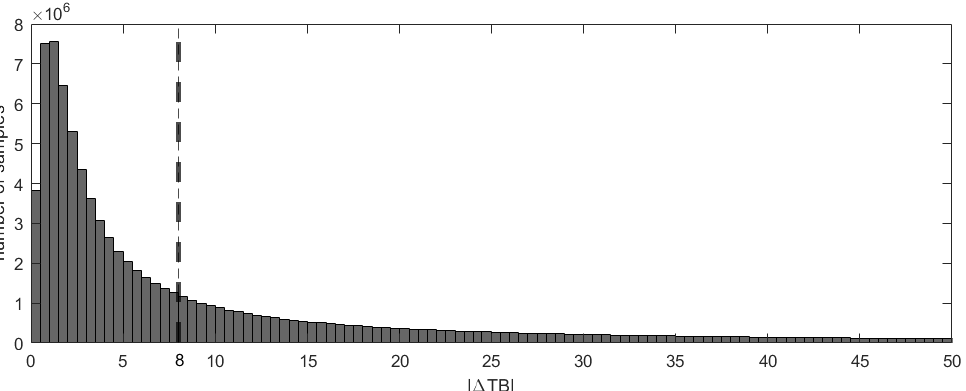
Figure 2. | ∆ TB | with β = 7 by SMAP TB data contained in SMAP L3 radiometer global daily 36 km EASE-grid freeze/thaw state; data over the northern hemisphere where 95% of samples are within 8 K.